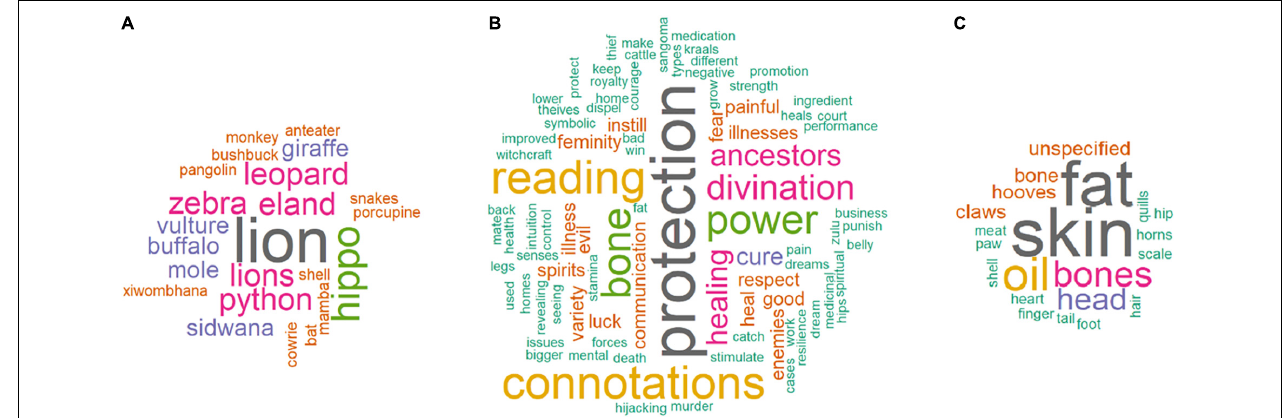
FIGURE 1 | Word cloud of (A) the cited common names ( n = 36 responses from five traditional healers) when asked to list the most profitable wildlife derivatives and species which have most increased in rarity in the last 5 years, (B) the cited medicinal and spiritual purposes for body parts provided by traditional healers ( n = 32), and (C) the commonly used body parts cited by traditional healers ( n = 68). Size of text is proportional to frequency of words used during the interviews. Frequency reflects both the number of traditional healers using the word and the number of times the word was used by the traditional